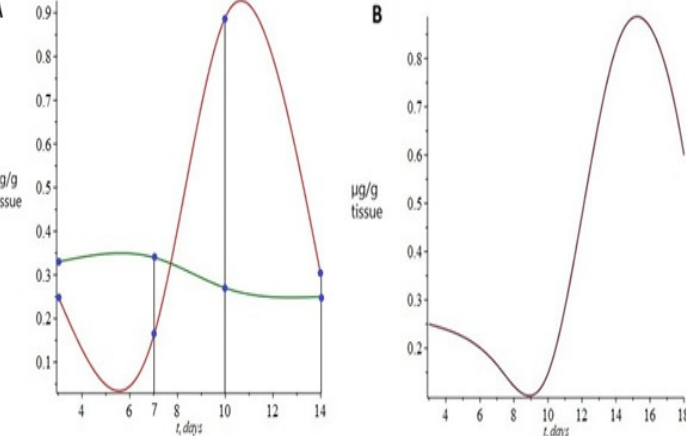
Figure 6. ( A ) Brain norepinephrine concentration of stressed rats (red points) and control rats (green points) during the post-stress period. The points have been connected by spline interpolation (red and green lines). ( B ) Brain norepinephrine concentration predicted by the mathematical model for the stressed rats is illustrated by a continuous red line.